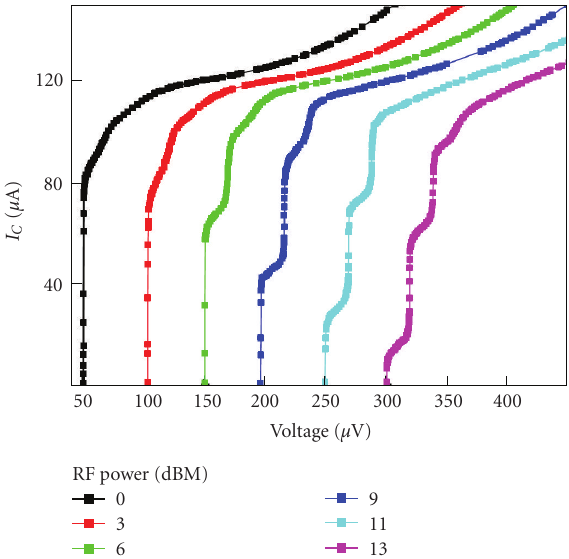
Figure 7: (From [27]) Current-voltage characteristics of an all- MgB 2 tunnel junction with an MgO barrier, under di ff erent RF irradiation power. The junction size is 60 × 60 μ m 2 . The curves are (cid:2) American Institute of Physics. horizontally shifted for clarity. c (cid:2) American